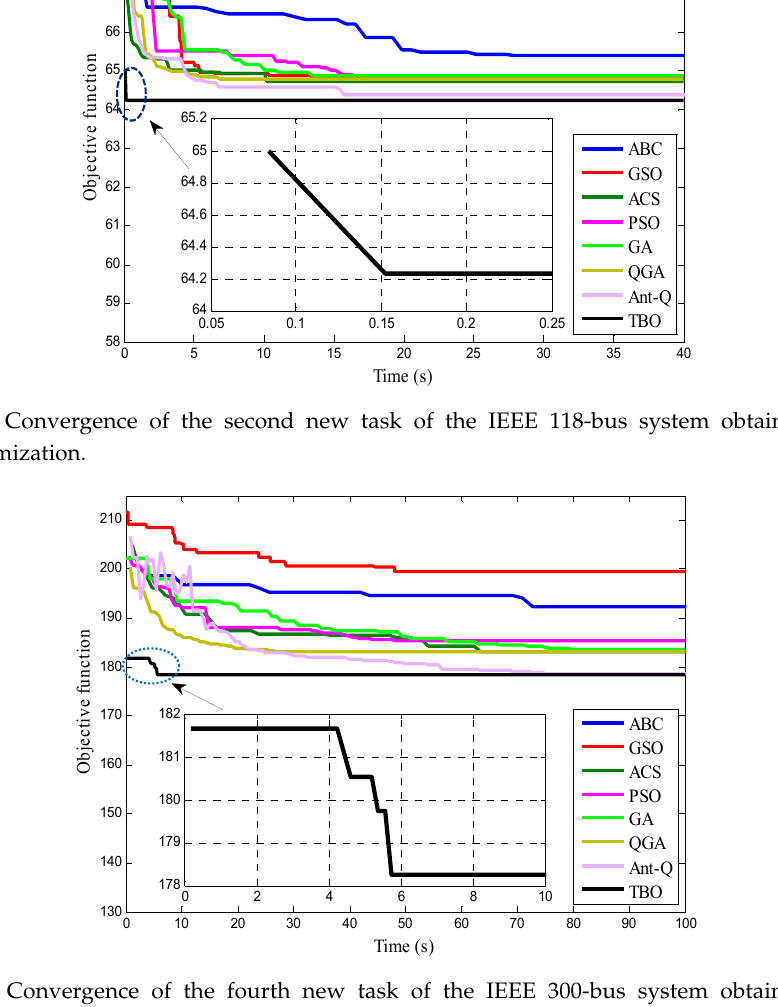
Figure 9. Convergence of the fourth new task of the IEEE 300-bus system obtained in the online optimization.